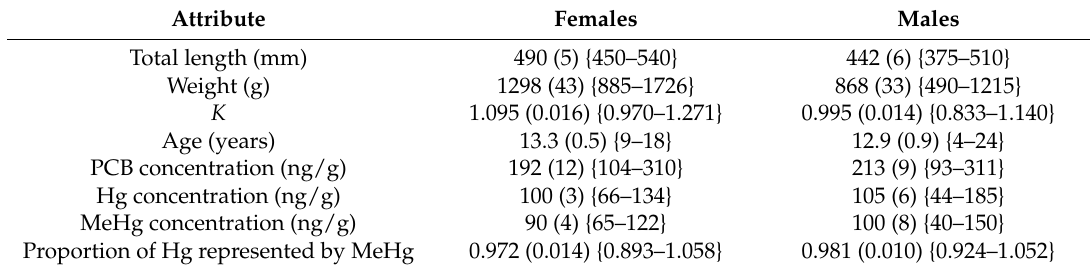
Table 1. Mean (standard error of the mean enclosed with parentheses) {range enclosed within brackets} values for total length, weight, Fulton’s condition K , age, polychlorinated biphenyl (PCB) concentration, total mercury (Hg) concentration, methylmercury (MeHg) concentration, and the proportion of Hg represented by MeHg, by sex, of the white suckers caught in the Kewaunee River (Wisconsin, USA), a tributary to Lake Michigan, during April